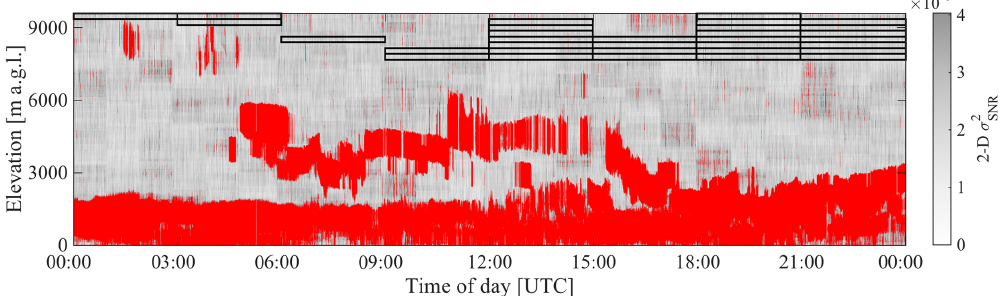
Figure 4. Time–height series of 2-D variance of SNR calculated from a Halo Doppler lidar at Hyytiälä, Finland, on 21 May 2014. The high variance areas (red) are masked using a dynamic threshold, which is found iteratively using the automatically selected reference areas (rectangles).